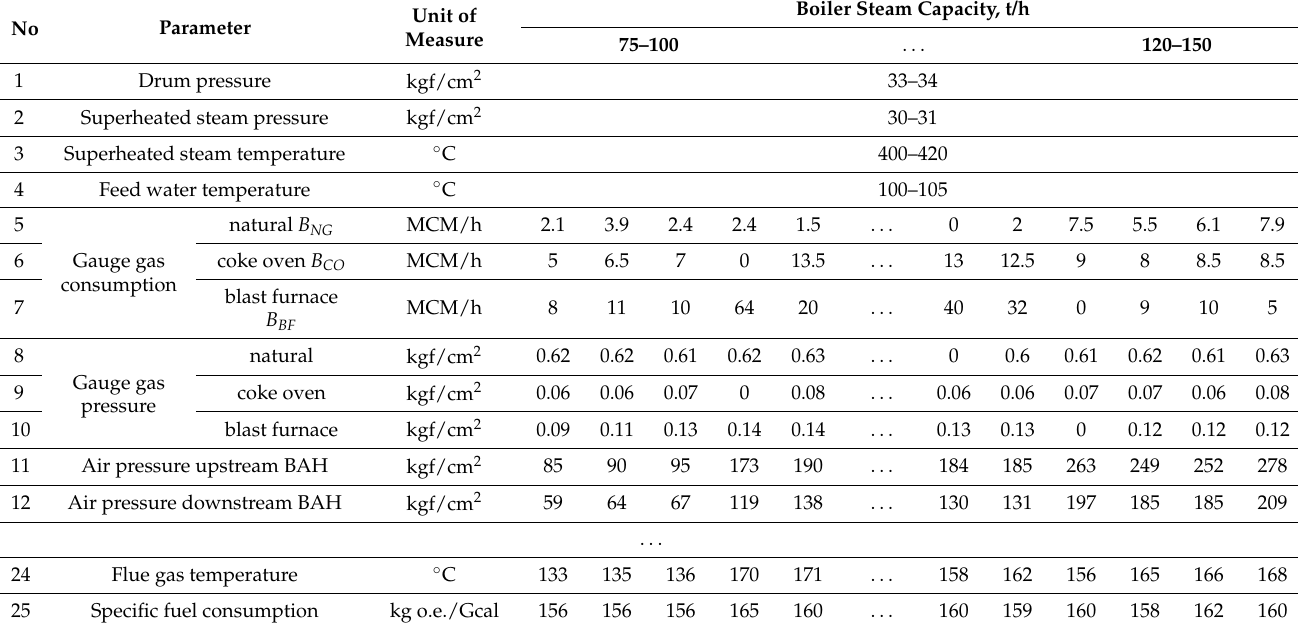
Table 1. Fragment of the Boiler Unit Performance Chart.